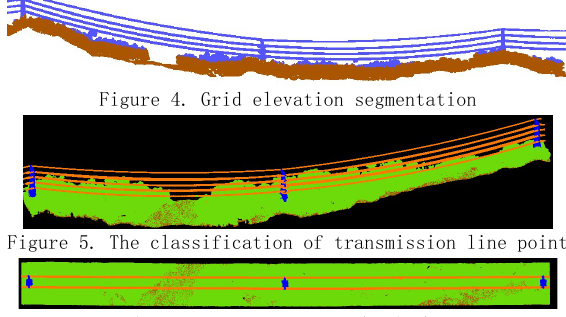
Figure 6. The top view of point cloud